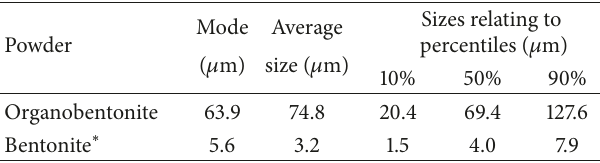
Table 2: Quantitative parameters of porous structure for bentonite and organobentonite